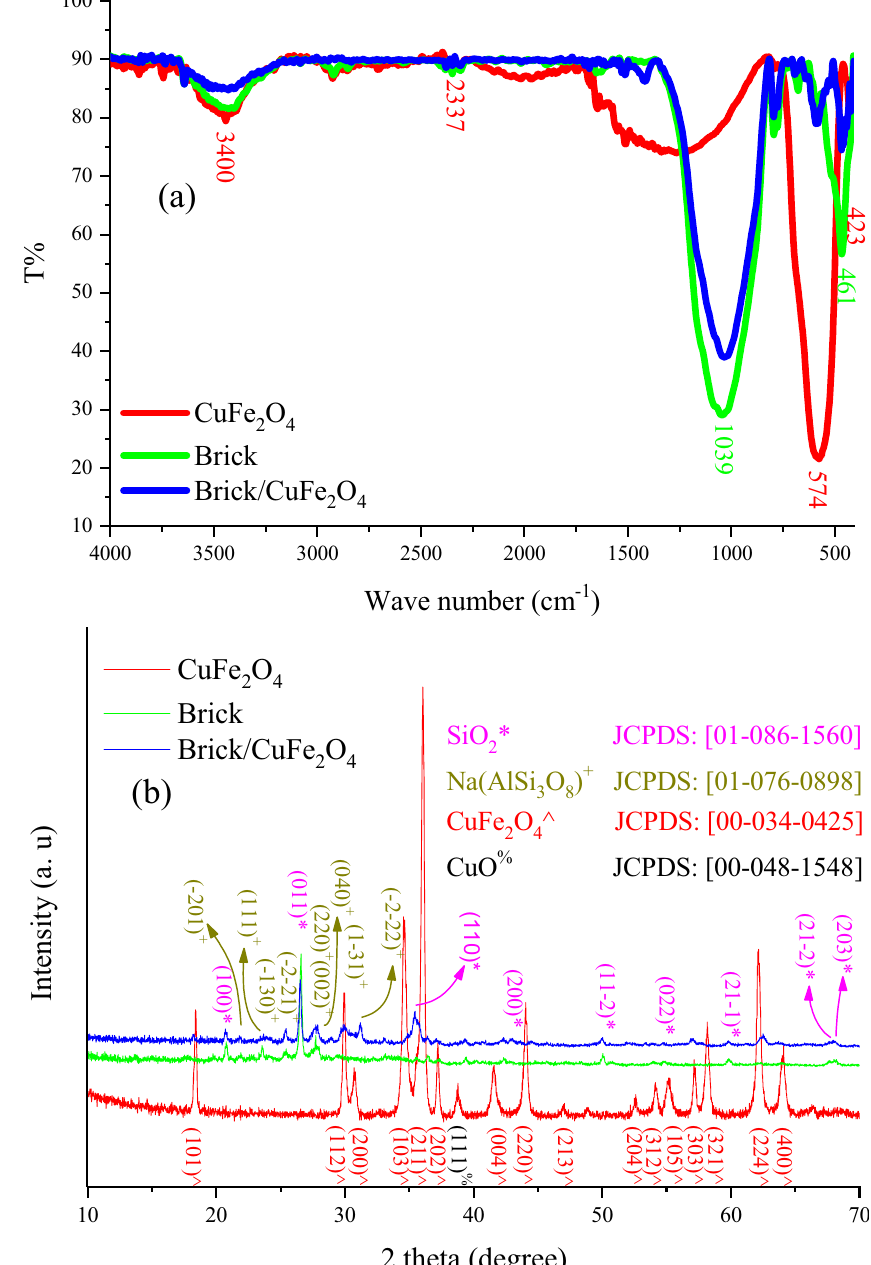
Figure 2. FTIR spectra ( a ) and XRD patterns ( b ) of CuFe 2 O 4 , brick, and brick/CuFe 2 O 4